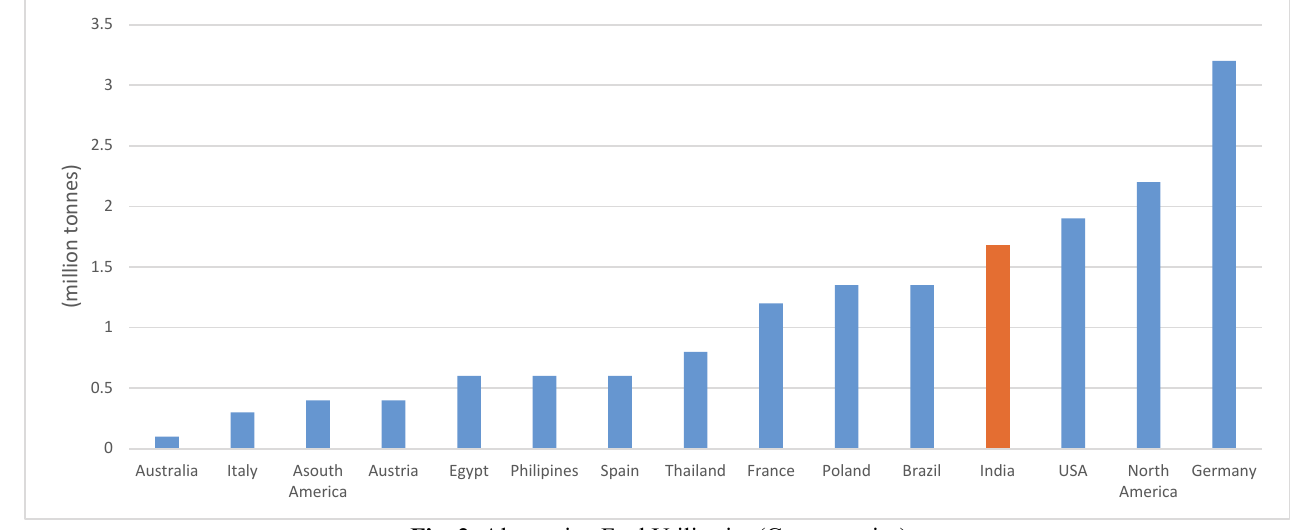
Fig. 2. Alternative Fuel Utilisation(Country